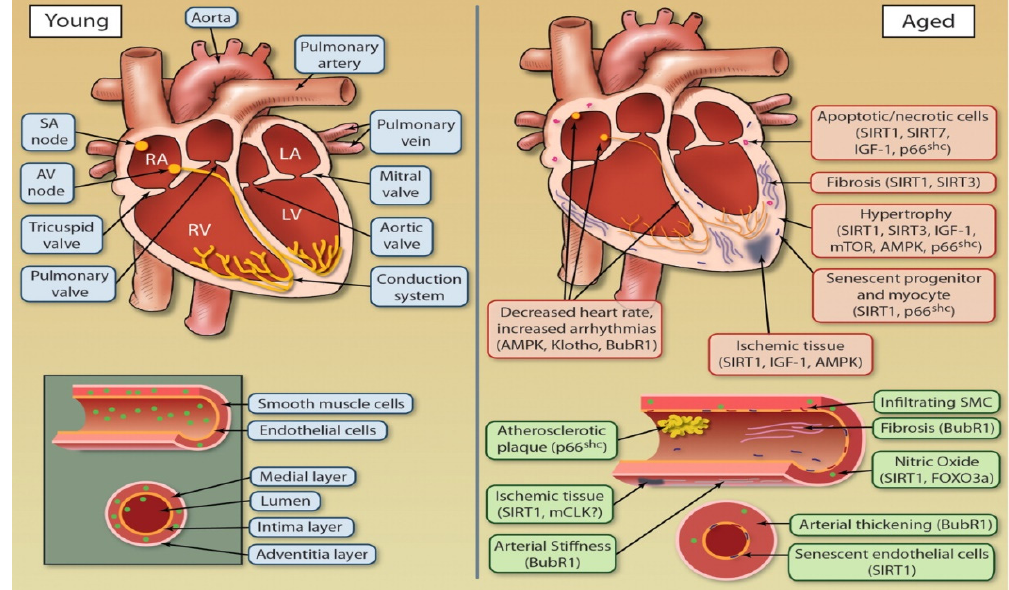
Figure 2. Comparative model of the aging heart and vasculature in young vs. older populations.